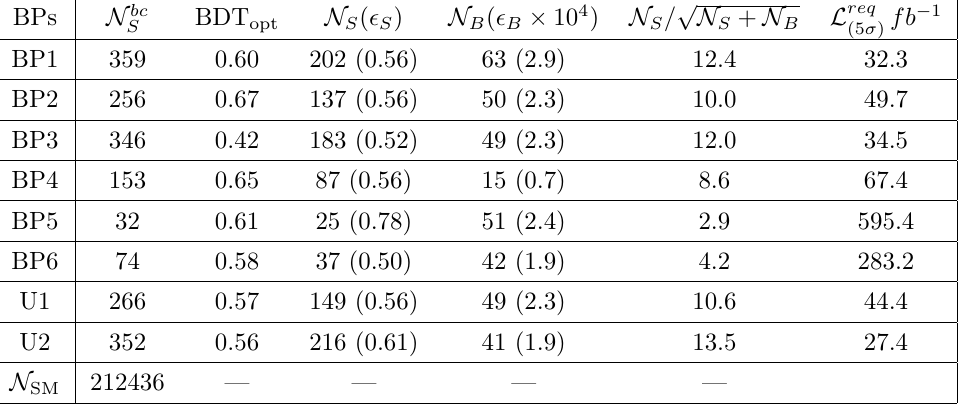
bc and background events before utilising the op- S N N SM and respec- N S N B